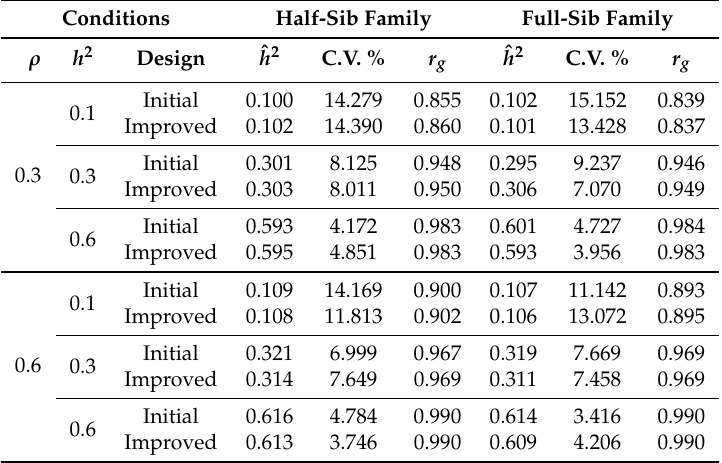
Table 4. Summary statistics based on Model 2 with Pearson’s correlation coefficient ( r g ) and estimated heritabilties (ˆ h 2 ) together with their coefficient of variation (C.V. %) for Ω had λ = 50 replicates each iterated p = 5000 times. Residuals errors were modeled using AR 1 ⊗ AR 1 spatial